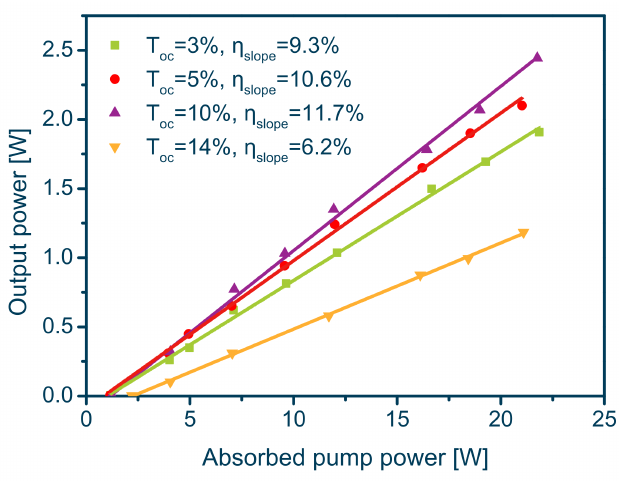
Figure 4. The output power of the Tm:LuAG laser as a function of absorbed pump power with different